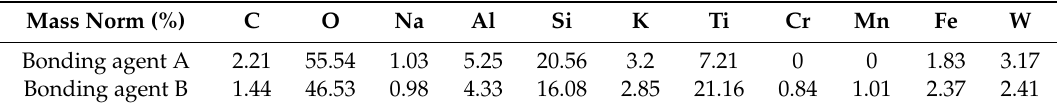
Table 3. Compositions and masses of the bonding agents used in this